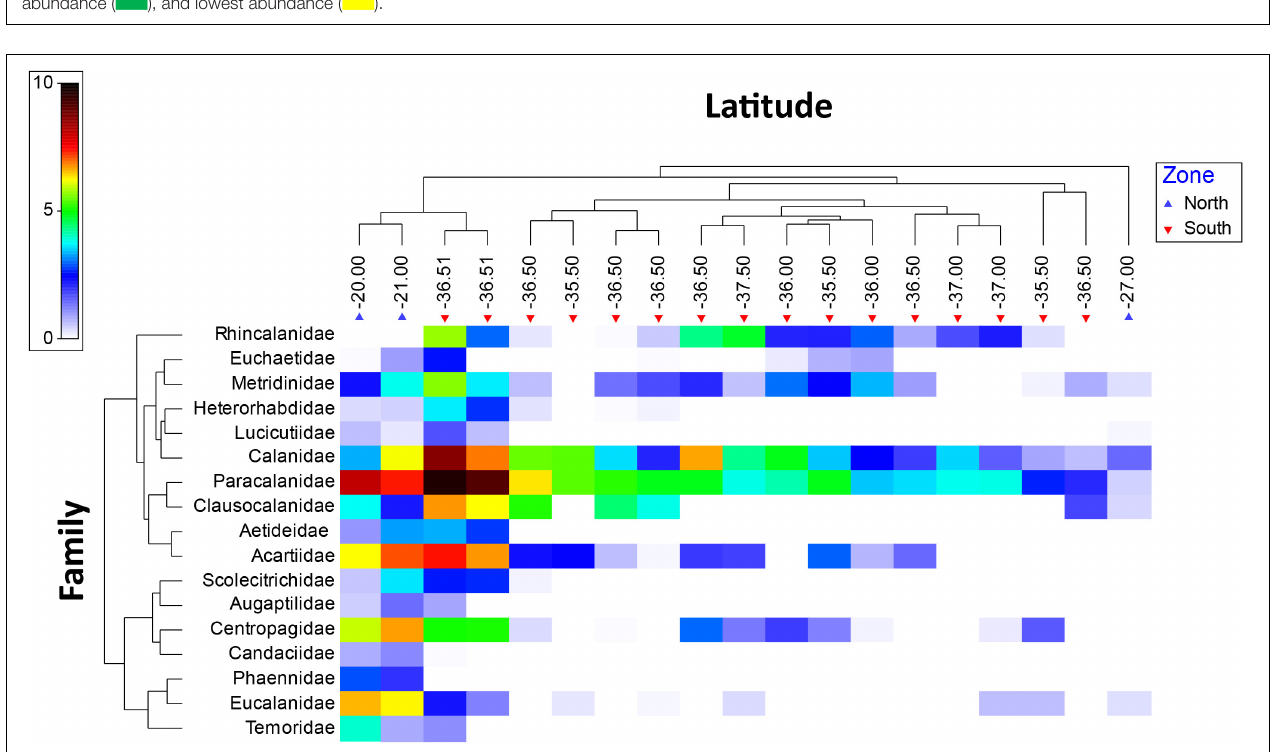
FIGURE 5 | Mean distribution of families presents found in the 0–200 m layer across alongshore gradient from the coastal zones of Antofagasta to Concepción between 2002 and 2015. For each family the location of the alongshore weighed abundance is shown (MWA: ), range of distribution ( ), site of greatest abundance ( ), and lowest abundance ( ).